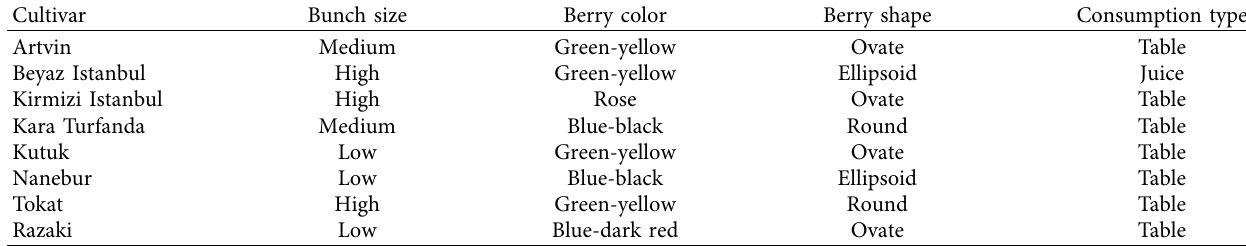
Table 1: Some important morphological characteristics of grape cultivars.